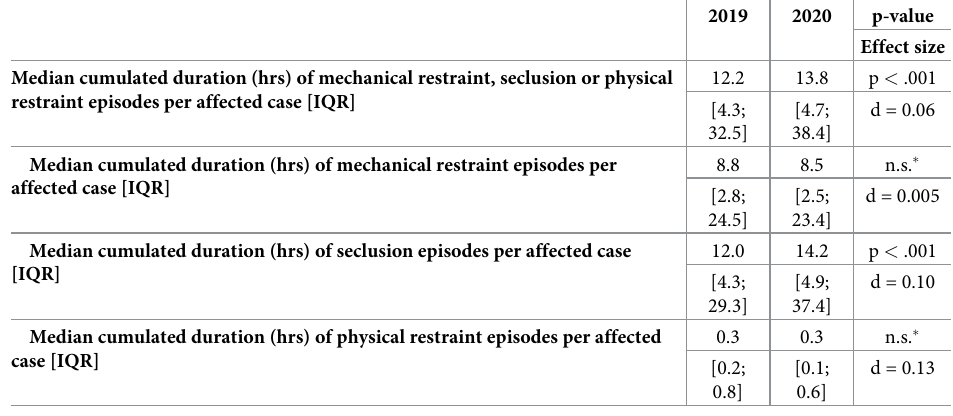
Table 3. Cumulated duration of coercive episodes per affected case in 2020 compared to 2019.